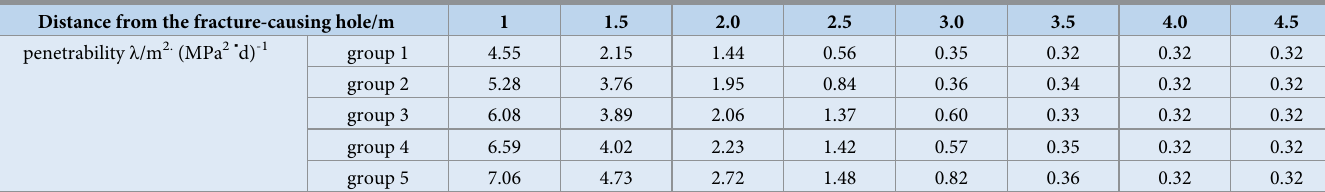
Table 6. Permeability coefficients of observation holes at different distances from fracture holes. Distance from the fracture-causing hole/m